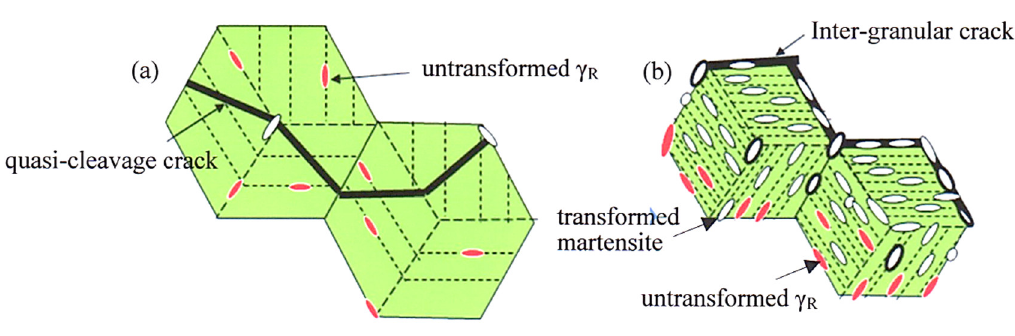
Figure 14. Brittle fracture morphology at − 196 °C appeared on the fracture surface of impact tested samples of ( a ) the 1.5 Mn and ( b ) 5 Mn steels subjected to the AC and IT processes. The 3 Mn steel shows the intermediate fracture mode in which quasi-cleavage fracture and inter-granular fracture are coexisting.